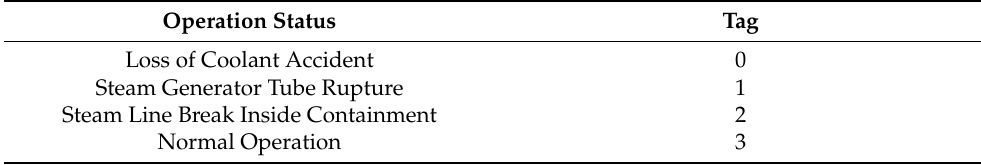
Table 2. Fault and label correspondence table.